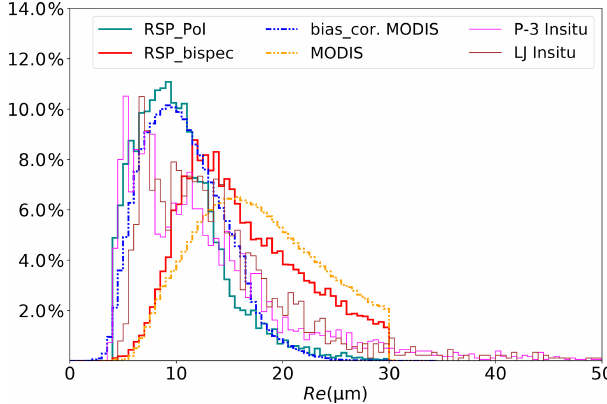
Figure 11. R e distributions from L2 RSP polarimetric R e , L2 RSP bi-spectral R e , L2 MODIS R e , L2 MODIS bias-adjusted R e , 1Hz P-3 R e derived in situ, and 1Hz Learjet (LJ) R e derived in situ us- ing all valid retrievals of warm oceanic clouds within the domain indicated in Fig. 1.